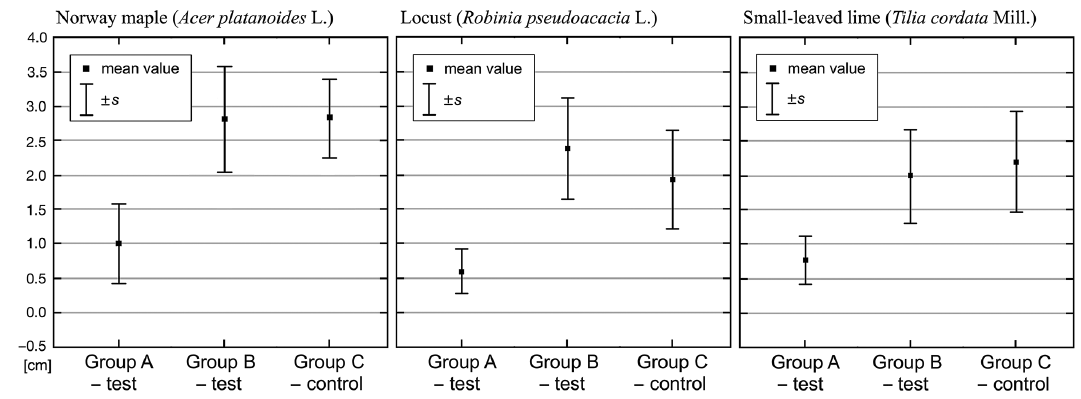
Figure 1. The mean yearly circumference’s increment of trunks at h = 1.3 m [cm] and standard deviation (± s [cm]) of the three most abundant tree species, where: test group A (Ursynów Park): trees damaged – exposed to earthworks due to roads modernization; test group B (Ursynów Park): trees undamaged – not exposed to earthworks due to roads modernization; control group